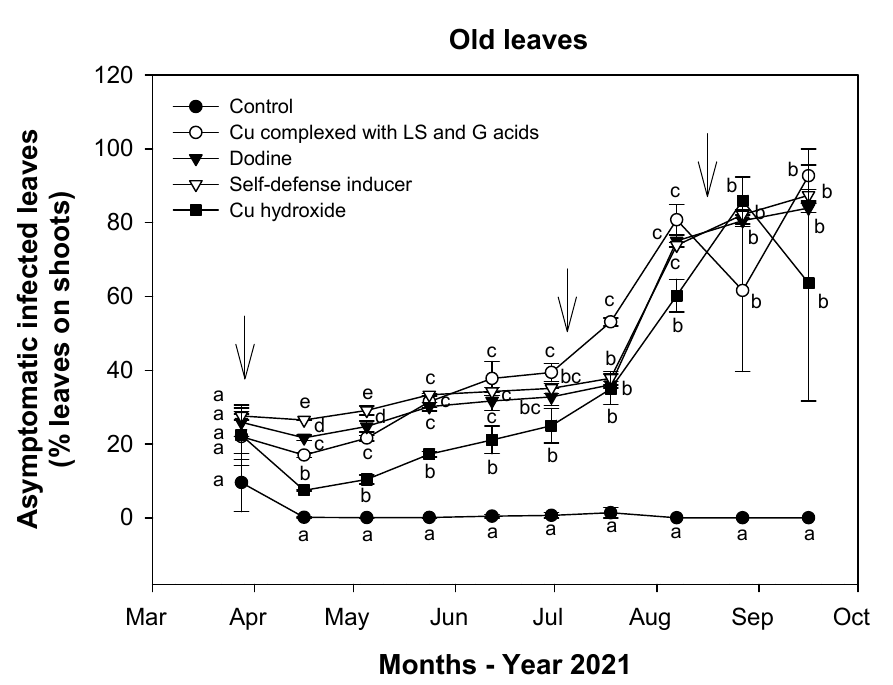
Figure 3. Effect of chemical treatments on asymptomatic Venturia oleaginea infection in old leaves (grown in 2020). Arrows indicate the dates of fungicide application. Bars represent the standard error. For each date, means followed by different are significantly different at p ≤ 0.05.